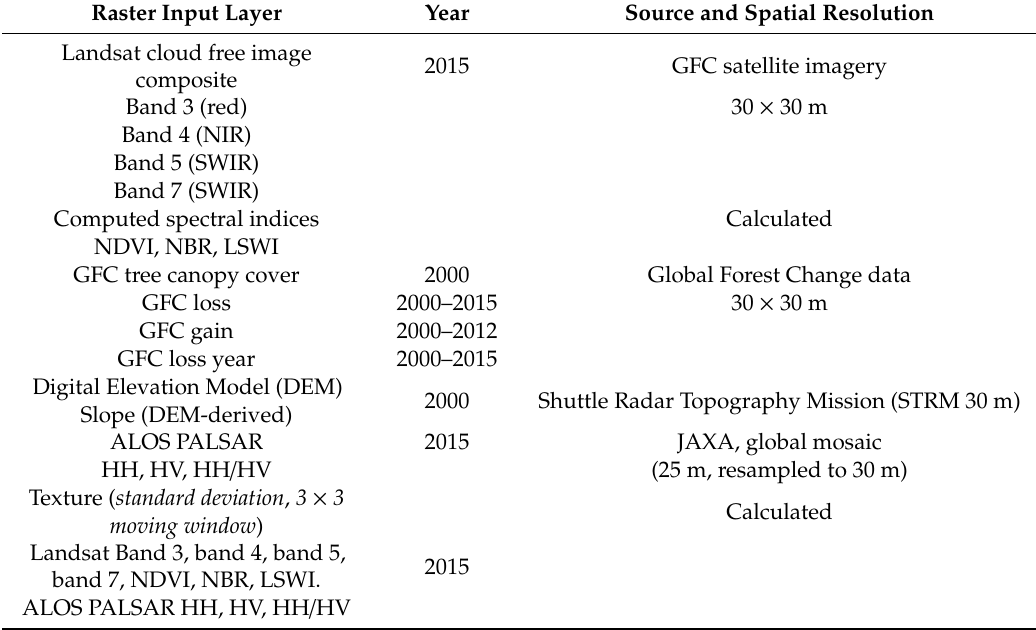
Table 1. List of input raster layers used in the agricultural land cover